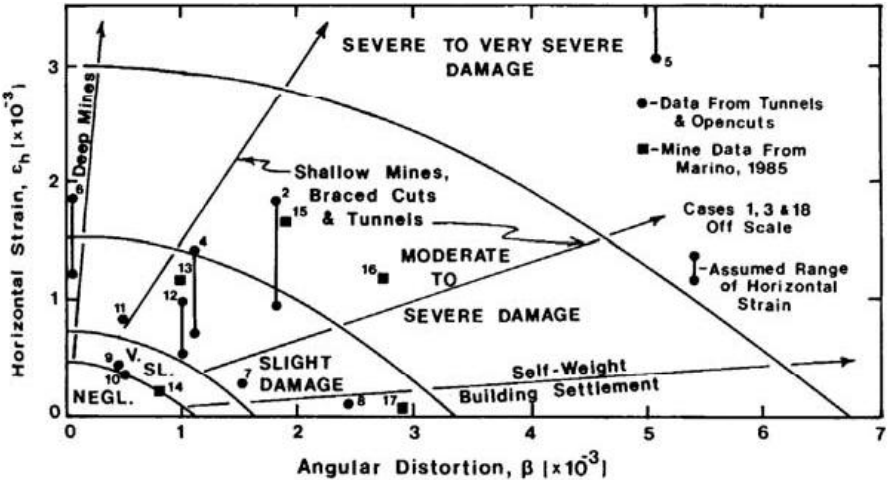
Fig. 2. Interaction diagram relating angular distortion and horizontal strain for different categories of damage (Boscardin and Cording, 1989).